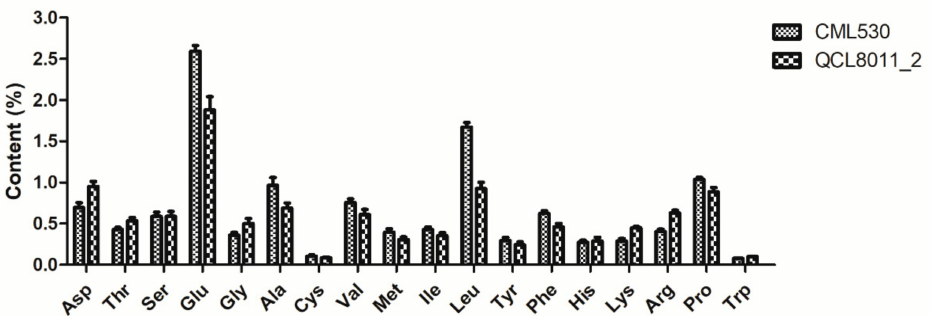
Figure 2. Contents of 18 free amino acids (FAAs) in mature kernels of CML530 ( O2O2O16O16 ) and QCL8011_2 ( o2o2o16o16